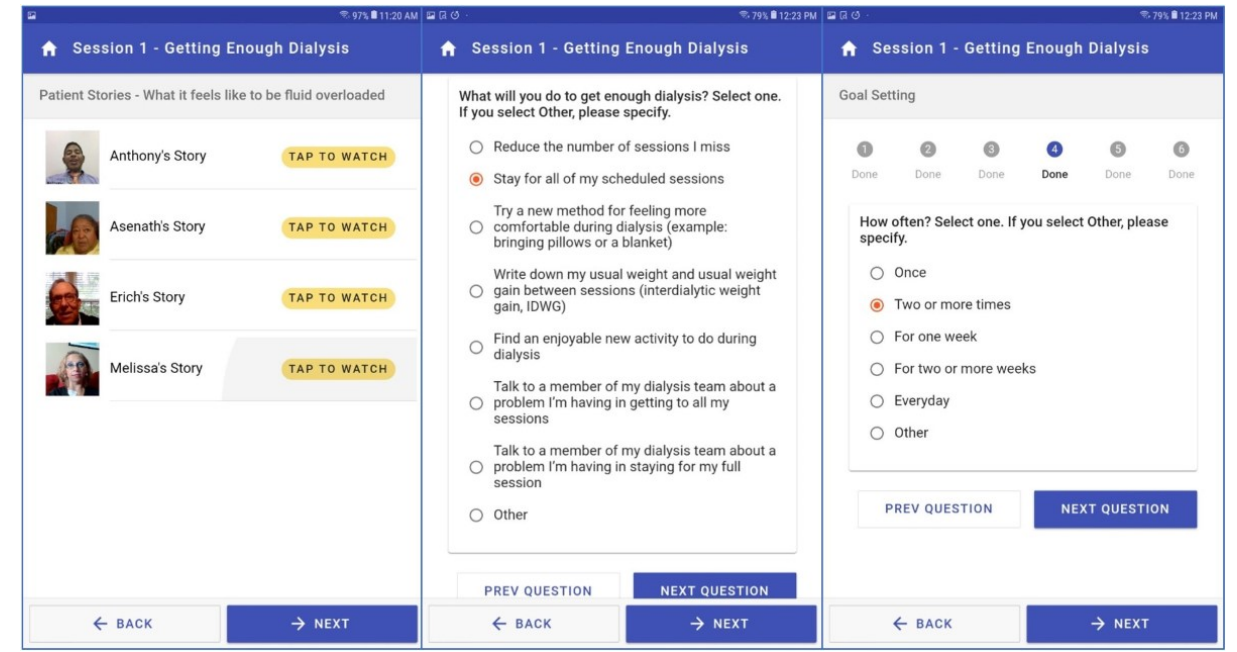
Figure 2. Screenshots from the tablet-based intervention showing a video library of hemodialysis patient stories (left), the quiz for module 1 (middle), and a question from the goal-setting module asking patients how often they will commit to adopting a certain behavior from the